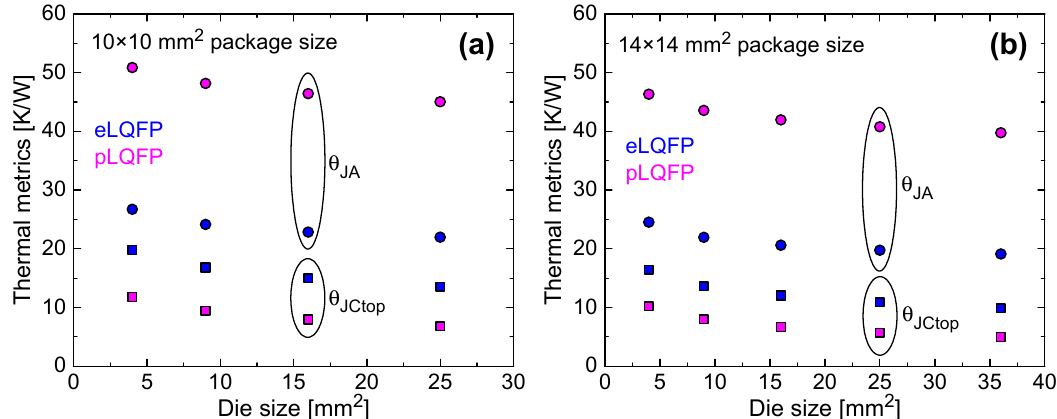
Figure 5. Thermal metrics ϑ JA (circles) and ϑ JCtop (squares) against die size: comparison between eLQFP (blue) and pLQFP (magenta) for ( a ) 10 × 10 and ( b ) 14 × 14 mm 2 package size with ( a ) 6 × 6 mm 2 and ( b ) 7.2 × 7.2 mm 2 die sizes.